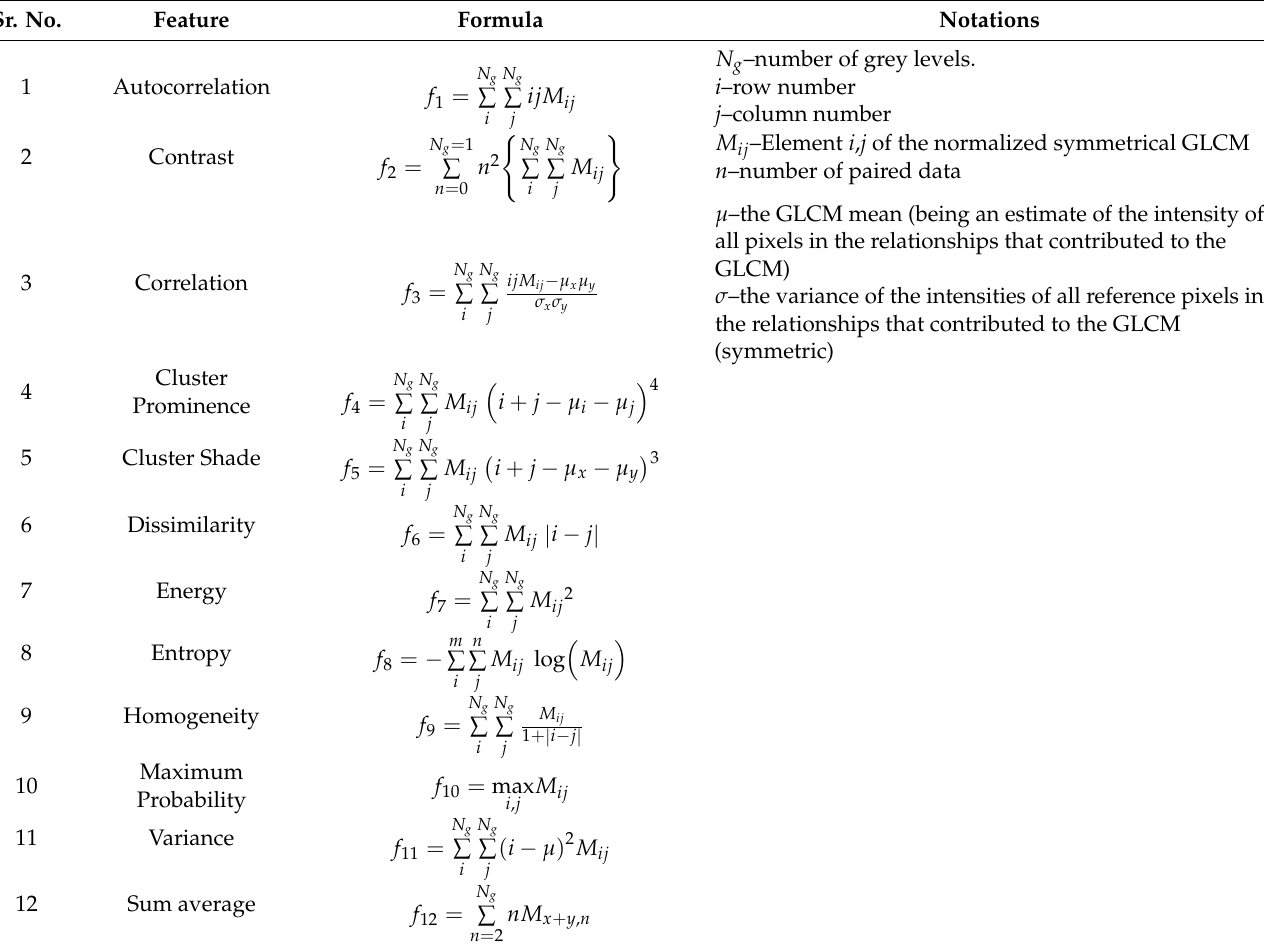
Table 3. GLCM features and their equations.